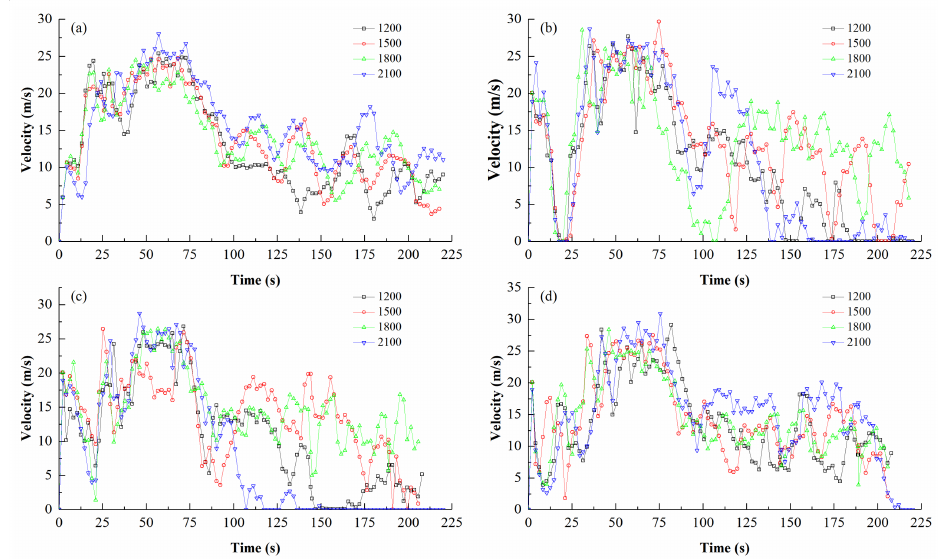
Figure 7. Influence of debris flow density on movement velocity of boulders with different shapes of boulders: ( a ) spherical, ( b ) cuboid, ( c ) rhombohedron, ( d ) cube.